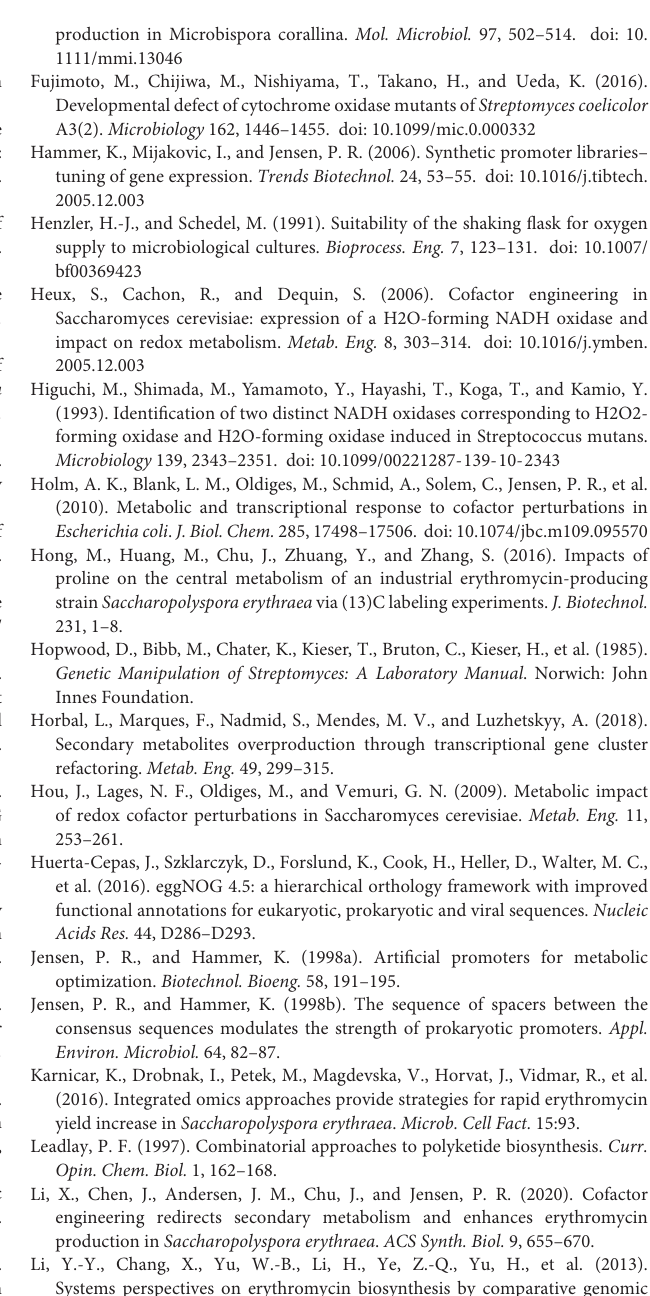
FIGURE S1 | Search for putative 16s rRNA promoters in S. erythraea .